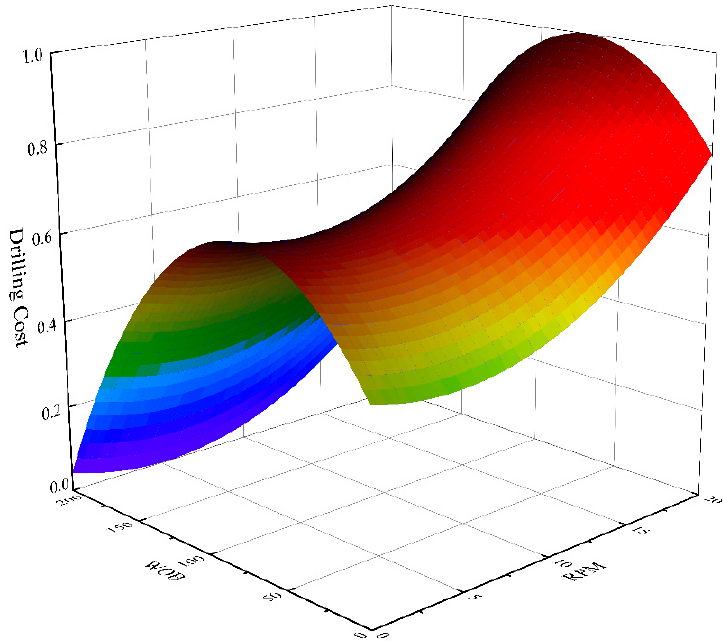
Figure 6. Drilling cost—Avoid high WOB and low Figure 6. drilling cost—Avoid high WOB and low RPM. Figure 6. drilling cost—Avoid high WOB and low RPM.